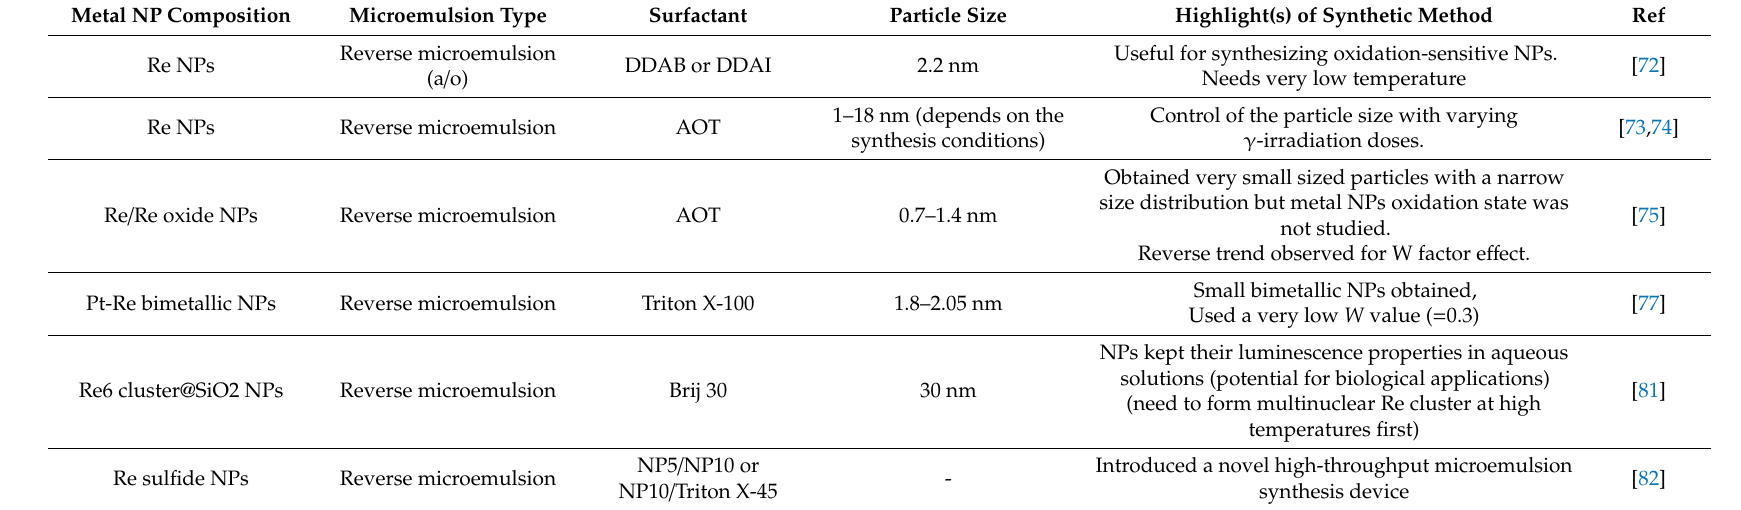
Table 1. A summary of recent advances in microemulsion-based synthesis of Re nanoparticles (NPs). DDAB—dimethyl dioctyl ammonium bromide;